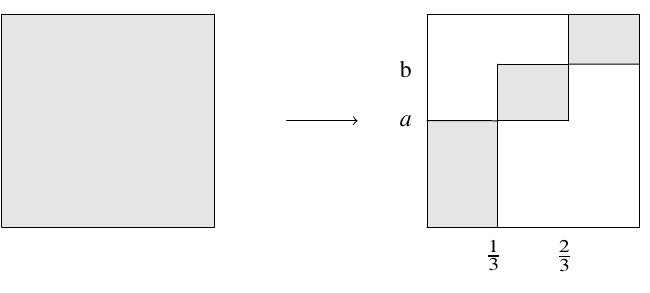
Fig. 1. The transform of the unit square by C